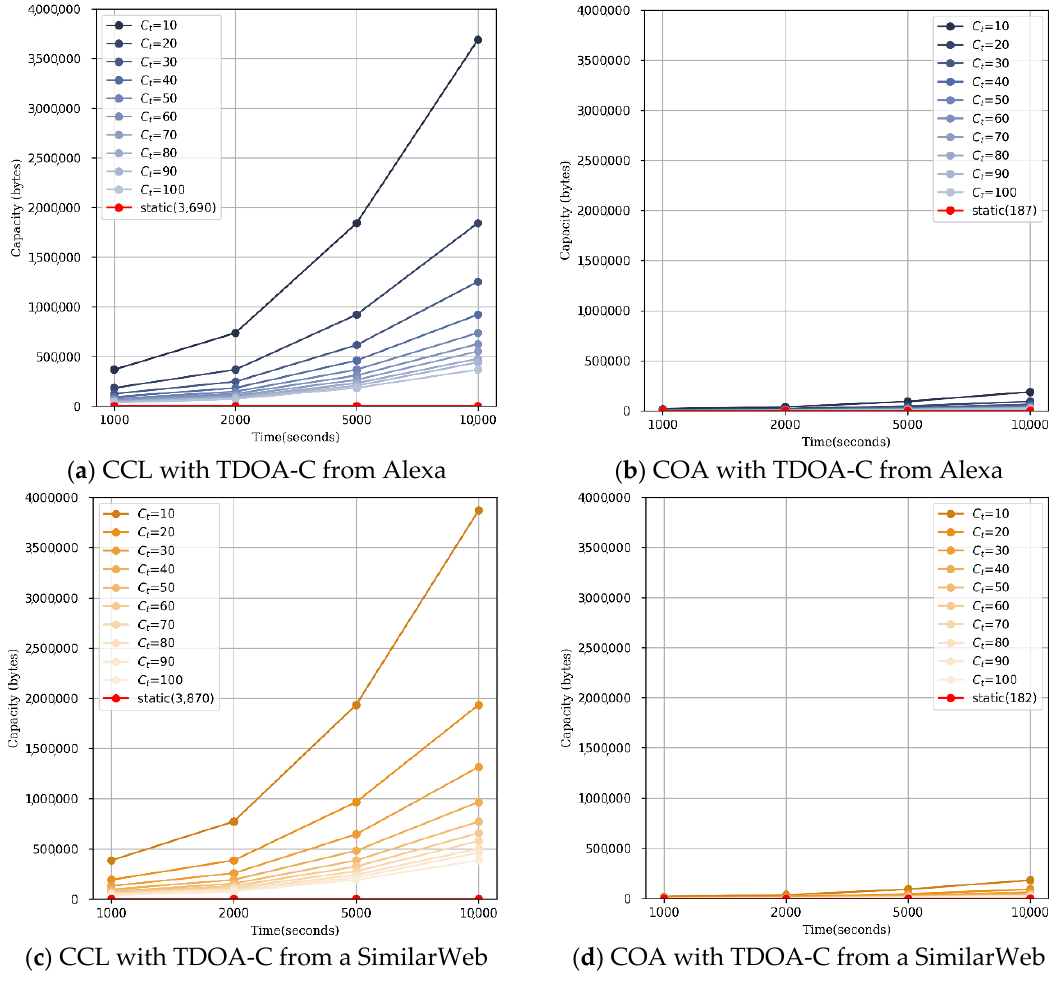
Figure 12. Average hiding capacities of our methods (CCL with TDOA-C and COA with TDOA-C) and existing methods (CCL and COA) as the value of the operation time increases from 1000 s to 10,000 s.